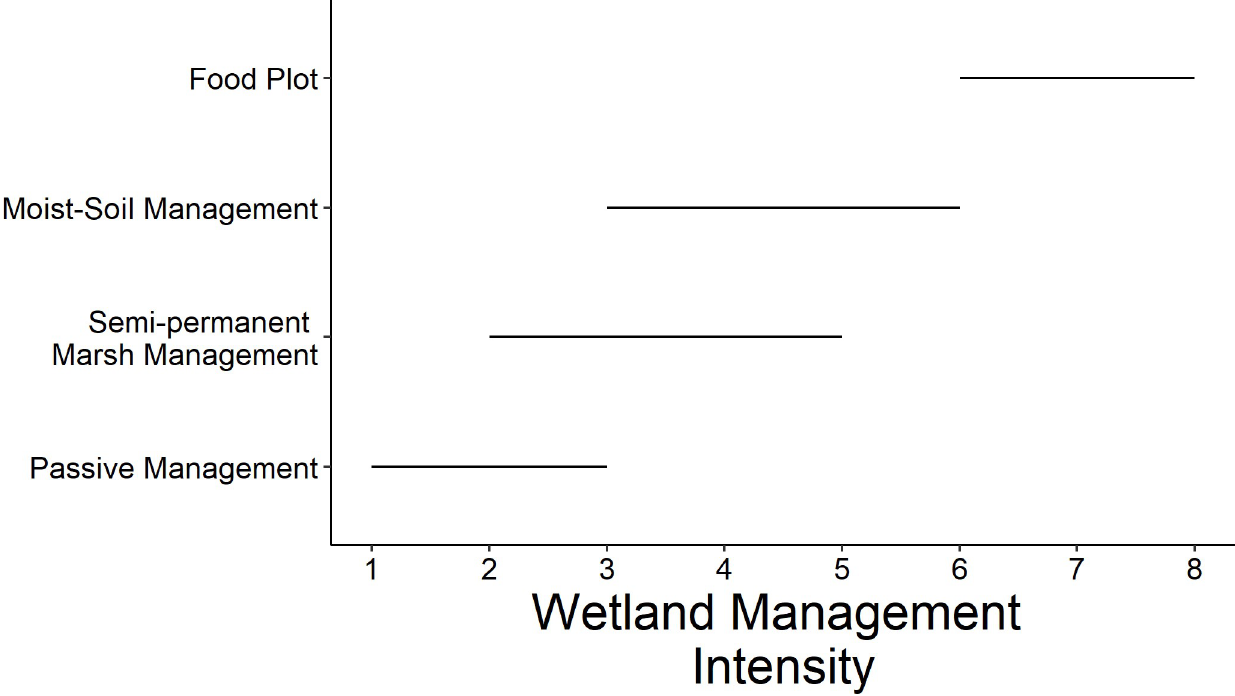
Fig 2. Example wetland management regimes (Y axis) and the range of waterfowl management intensity values (X axis) typically encountered based a visual index of management activities and capabilities present (1 [low intensity or passive management]– 8 [intensive/active management]).